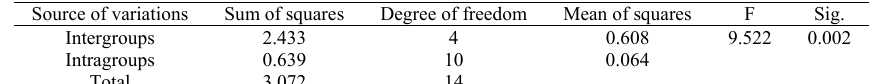
Table 17: Tukey’s test α subsets at the level of 0.05% Treatment concentrations 1